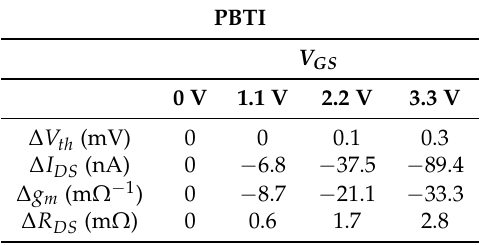
Figure 17. Simulation results for BTI in pMOS I-V curves, ( a ) threshold voltage, and ( b ) drain current degradation for one year of continuous operation. Table 2. Electric parameters’ degradation for the nMOS transistor under one year of continuous